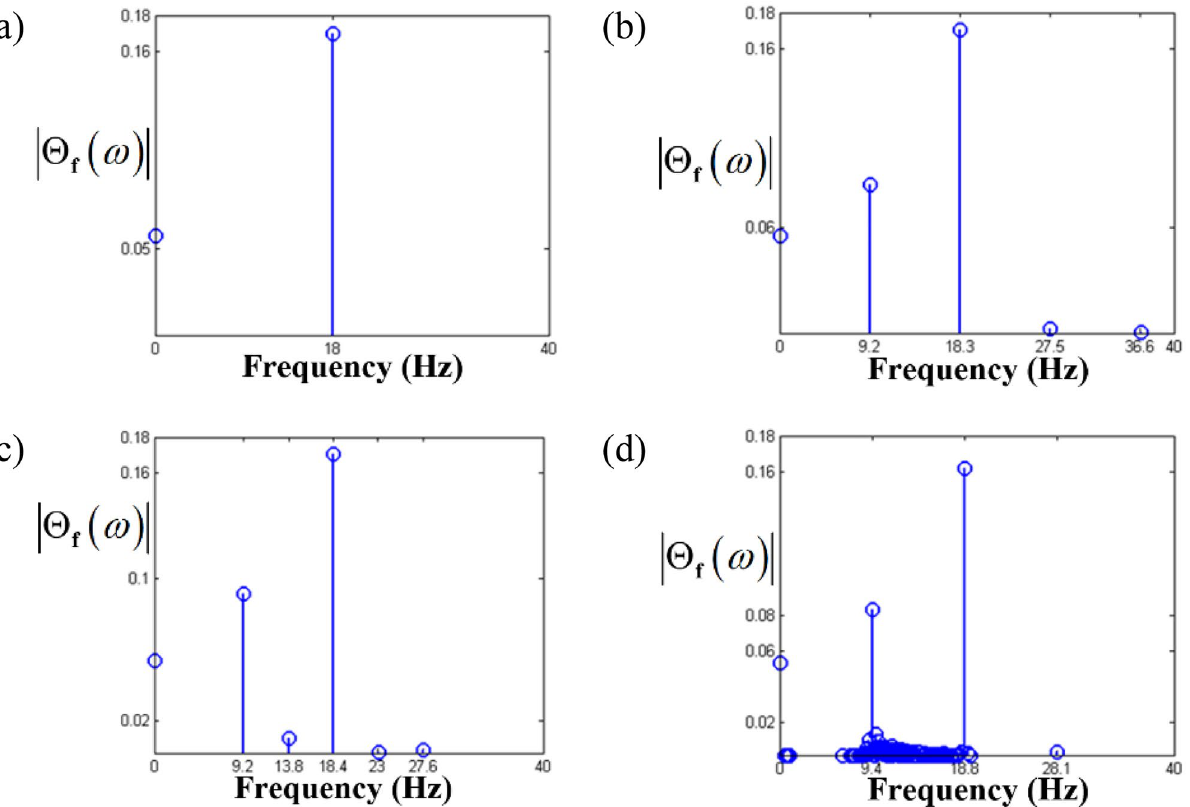
Figure 11. Comparisons of FFT results based on 200 cycles of time histories: ( a ) FFT results at ̟ = 0.98 ; ( b ) FFT results at ̟ = 0.995 ; ( c ) FFT results at ̟ = 1.0 ; (d) FFT results at ̟ = 1.02